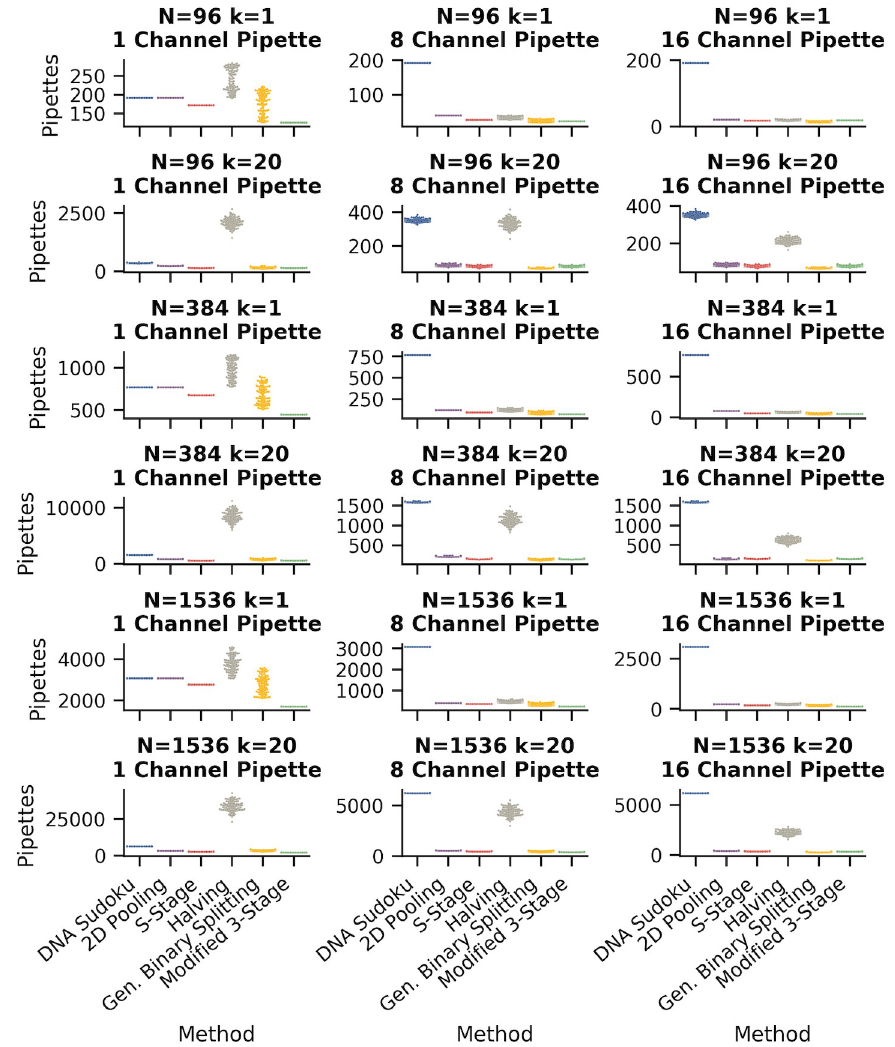
Fig 10. Comparison of the number of pipettings for each pooling method. The number of pipettings required for each pooling method is an indicator of method simplicity and reproducibility. The swarm plots show the distribution of the number of pipettings required to create pools for each method using 1-, 8-, and 16-channel pipettes (columns). The DNA Sudoku method does not benefit from the use of multichannel pipettes so the number of pipettings is the same across each row. These results are from the same set of simulations as shown in Fig